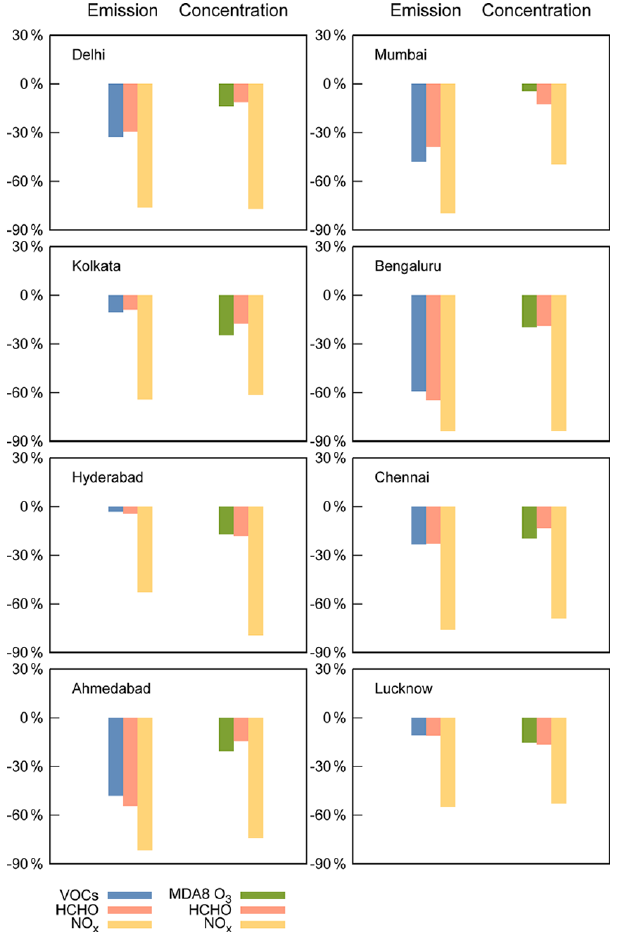
Figure 8. Predicted relative changes in concentrations of O 3 , HCHO, and NO x and emissions of VOCs, HCHO, and NO x in eight major cities of India in Case 2 to Case